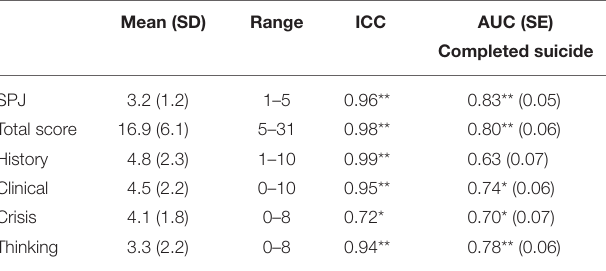
TABLE 2 | Descriptive and inferential statistics for the RoSP in study 1.